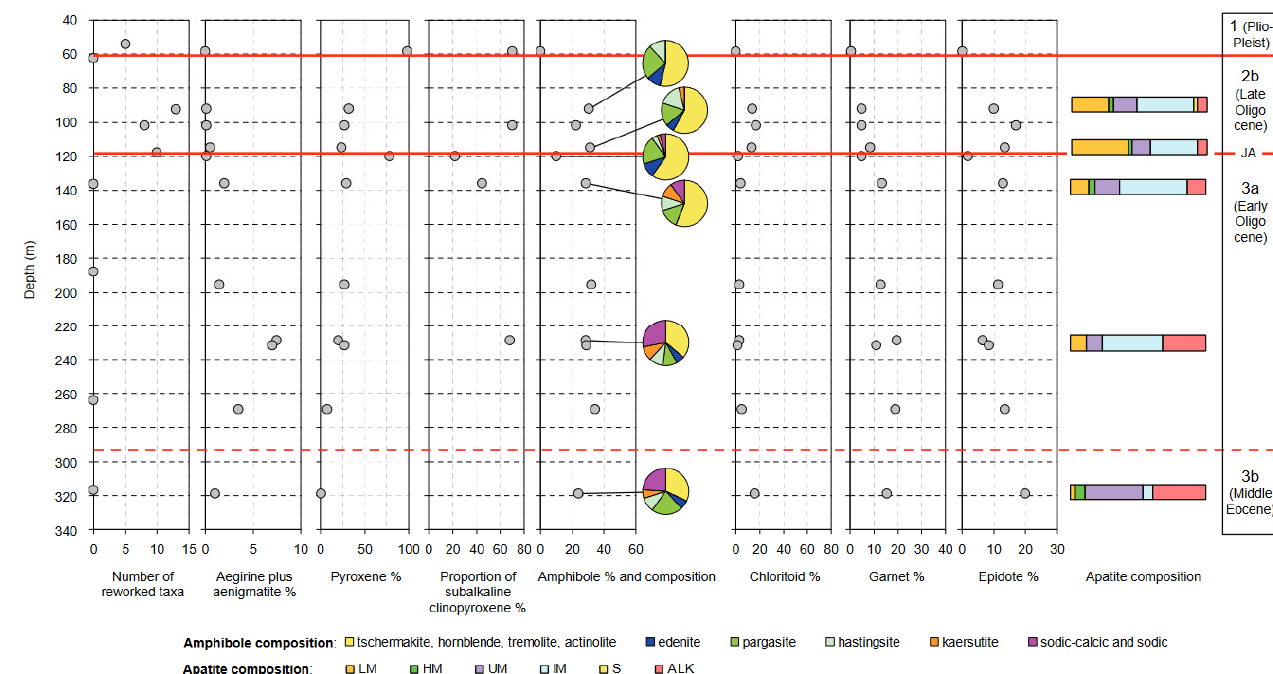
Figure 6. Variations in heavy mineral provenance character and reworked taxa at DSDP Site 349. LM = low and medium grade metamorphic and metasomatic, HM = high grade metamorphic, partial melts, leucosomes, UM = ultramafic igneous, IM = mafic igneous including mafic I-type granitoids, S = felsic igneous including S-type and felsic I-type granitoids, ALK = alkaline igneous.